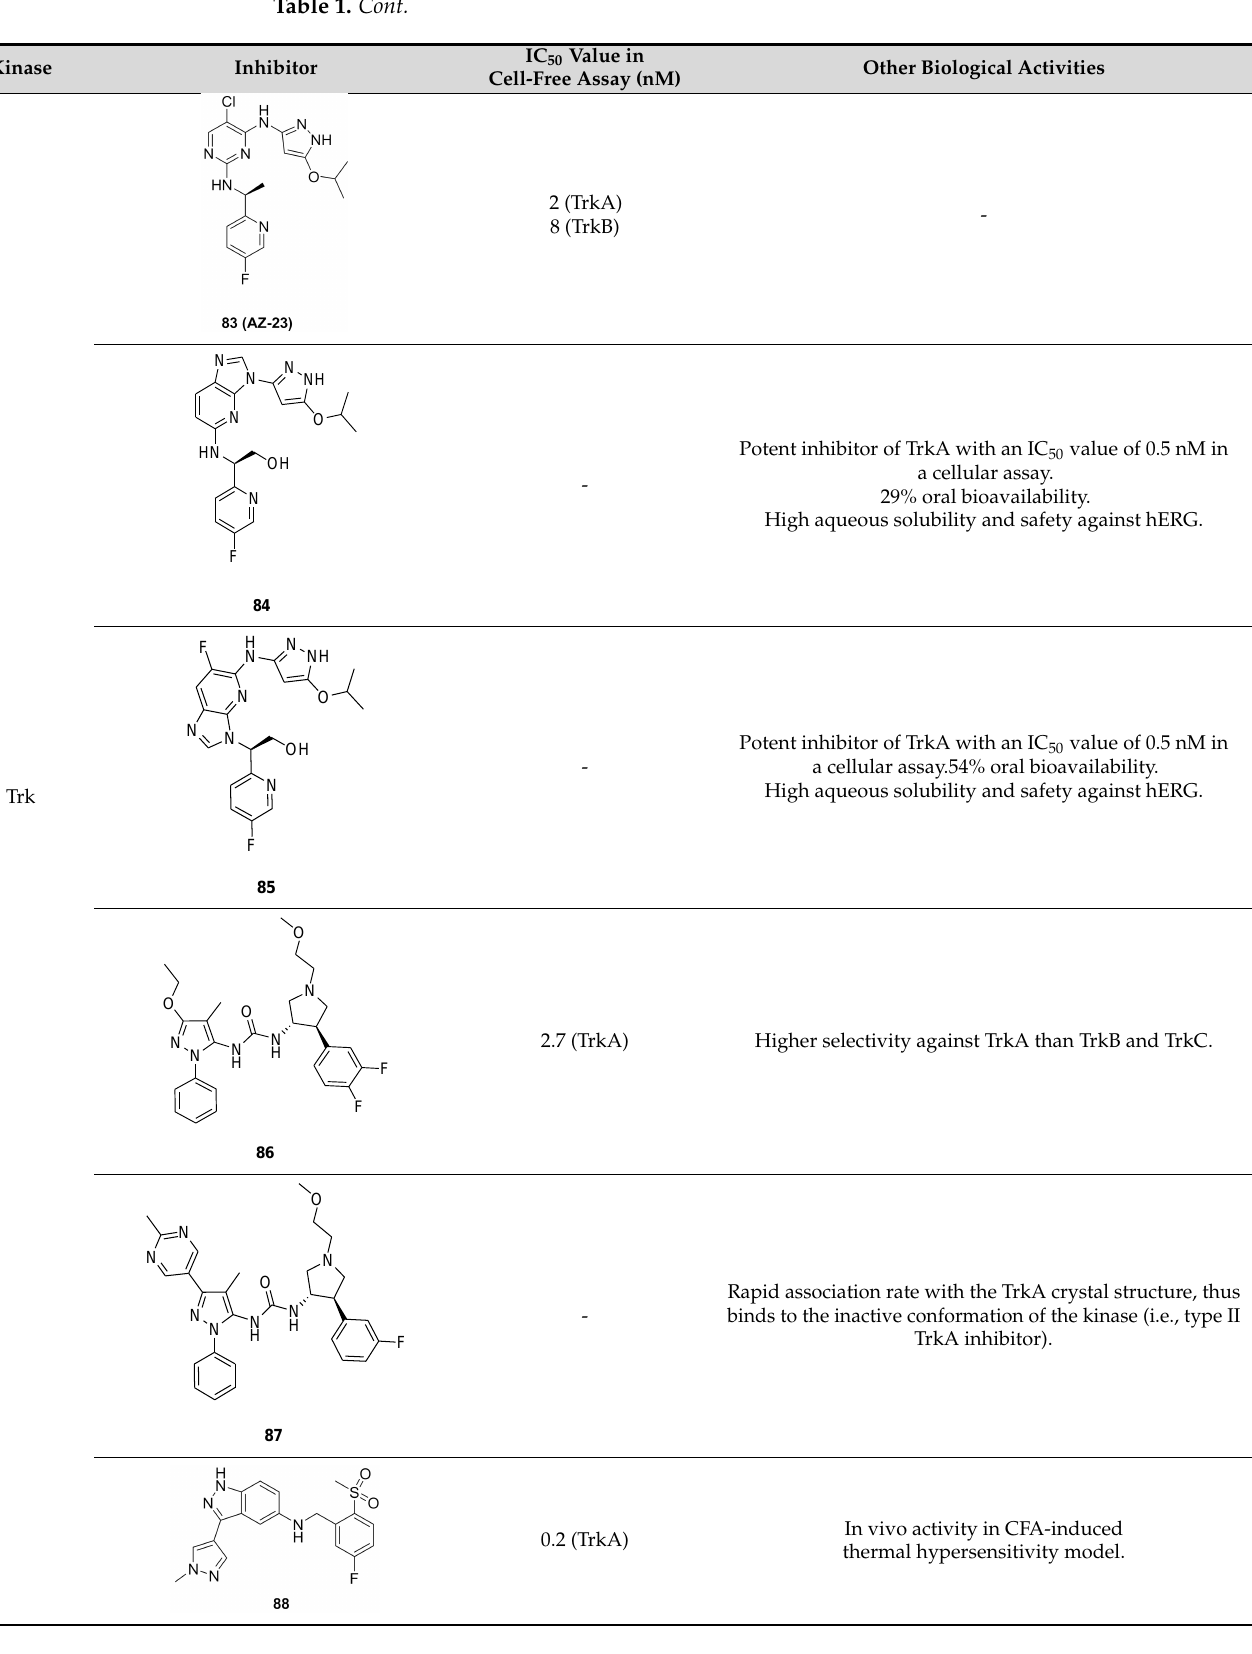
Potential inhibitor of collagen I and α -SMA 30 (TGFβ type p rotein and mRNA expressions in TGFβ -in- Table 1. Cont. duced LX-2 human hepatic stellate cells. 1/ALK5) duced LX-2 human hepatic stellate cells. IC 50 Value in Other Biological Activities Cell-Free Assay (nM)